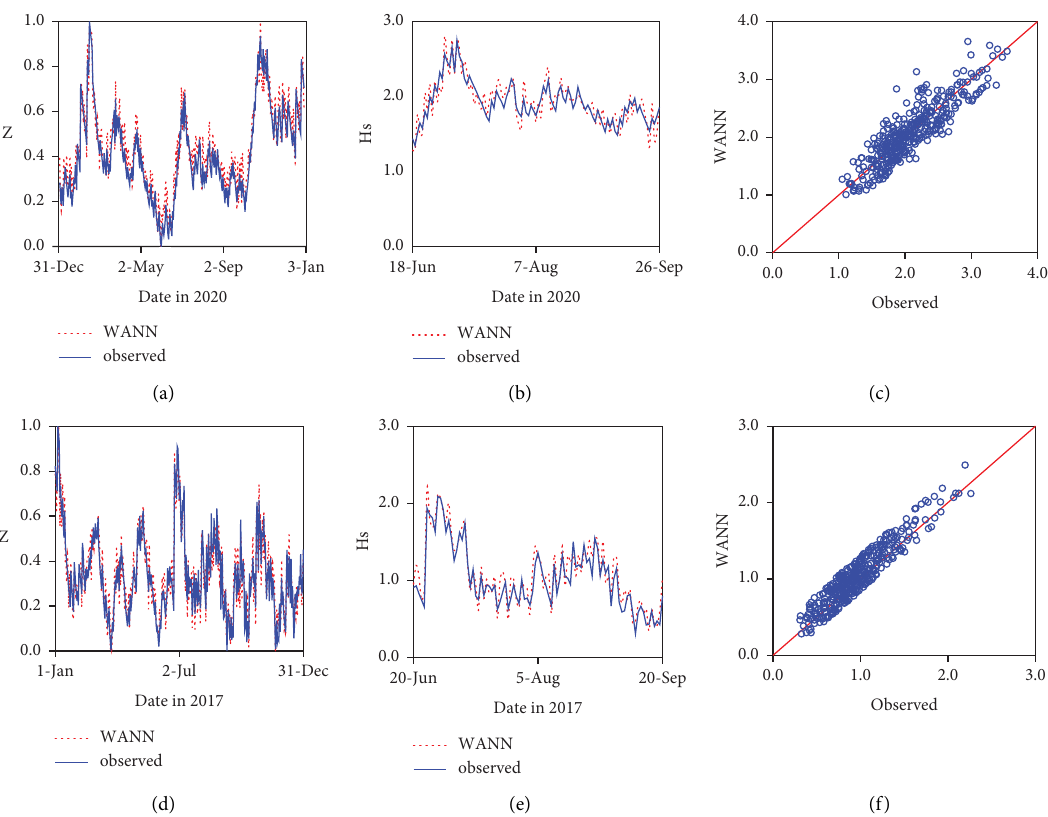
Figure 5: Times series of test and train normalized signifcant wave height and the corresponding scatter diagram by the WANN model (a–c) in the Hambantota Port (2020) and (d–f) in the Sanmen Bay